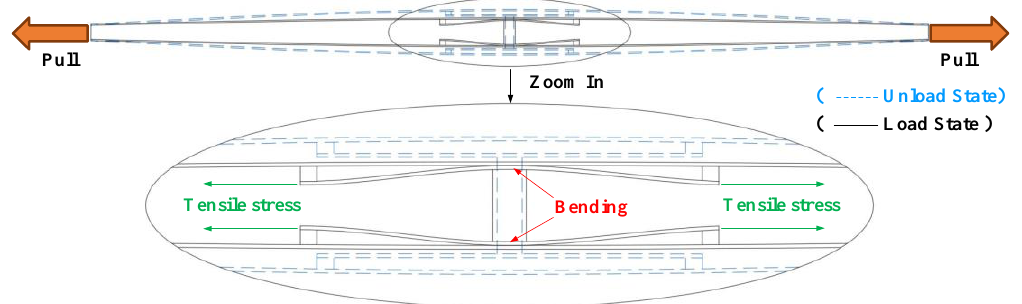
Figure 4. The deforming mechanism of the piezoelectric beams.